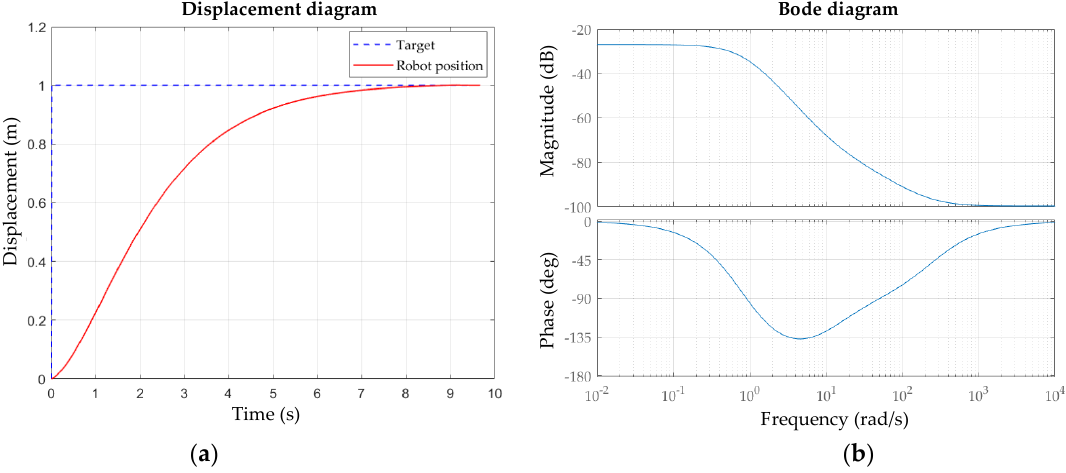
Figure 7. ( a ) Robot displacement profile in the HRH test and ( b ) Bode magnitude and phase plot.